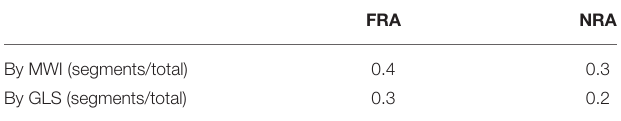
TABLE 4 | Amount of reclassified FRA and NRA